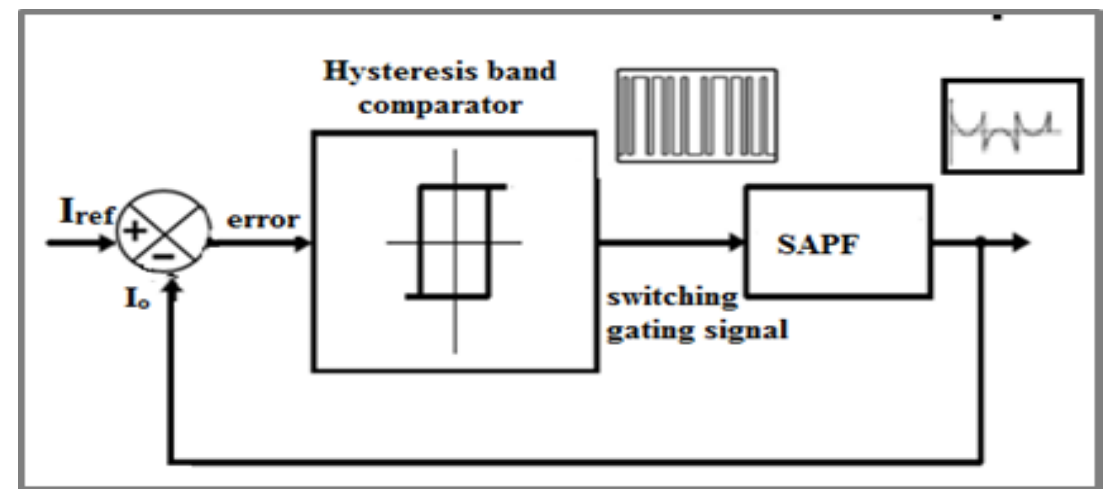
Figure 3. Hysteresis current controller response.